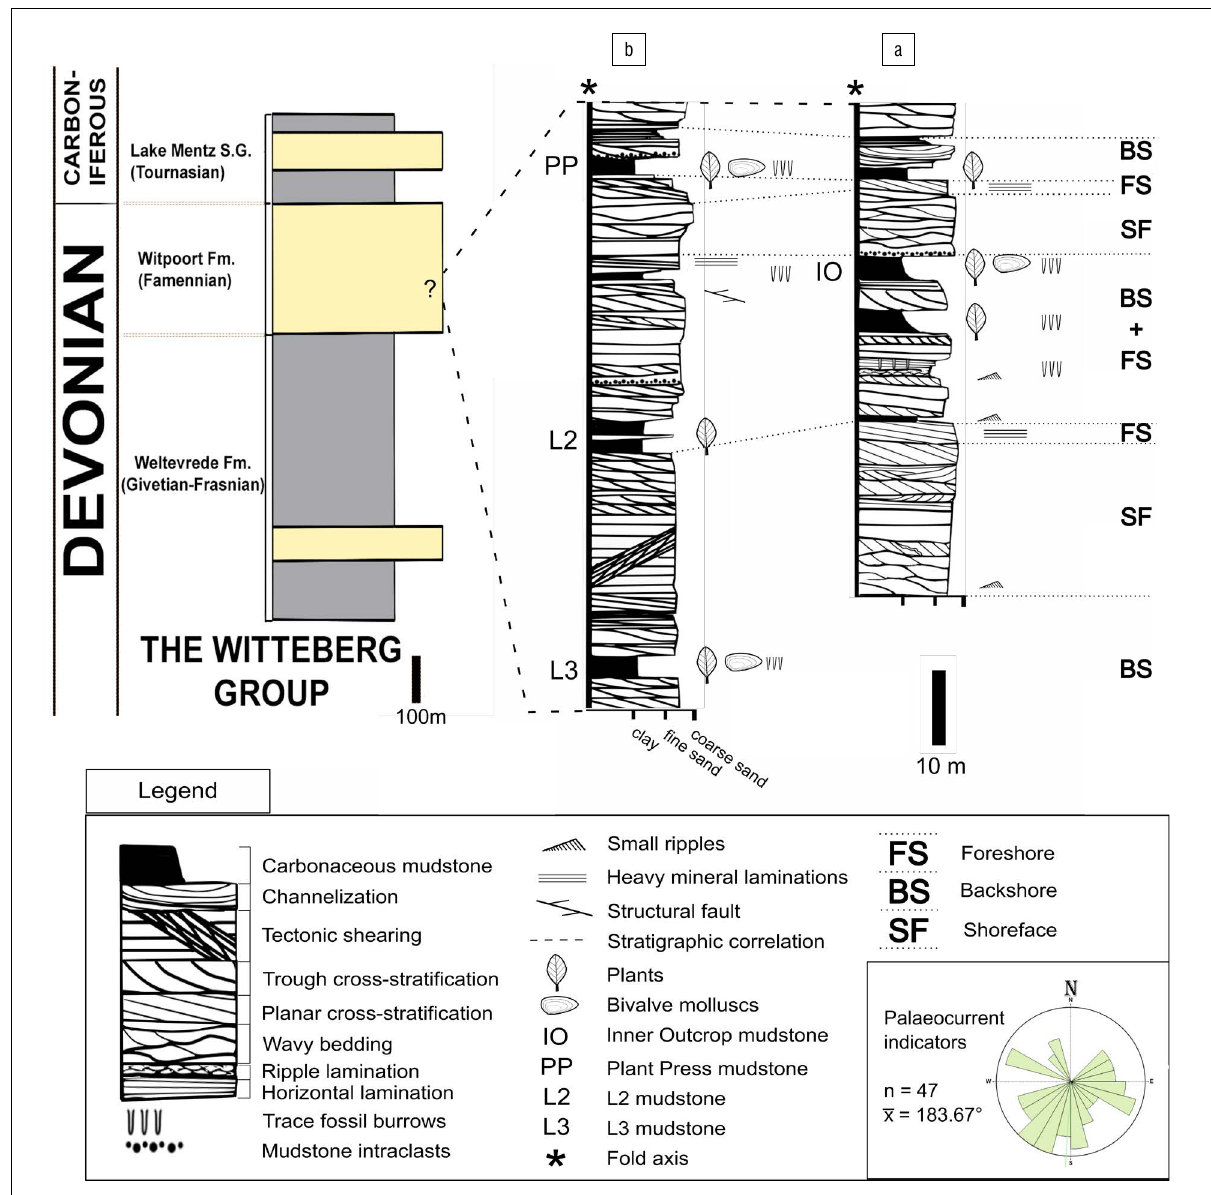
Figure 3: Stratigraphic log of the Coombs Hill road cutting showing (a) the right-way-up portion and (b) the overturned portion of the succession (refer to Figure 2). Cumulative palaeocurrent indicators for the whole succession are inset at the bottom